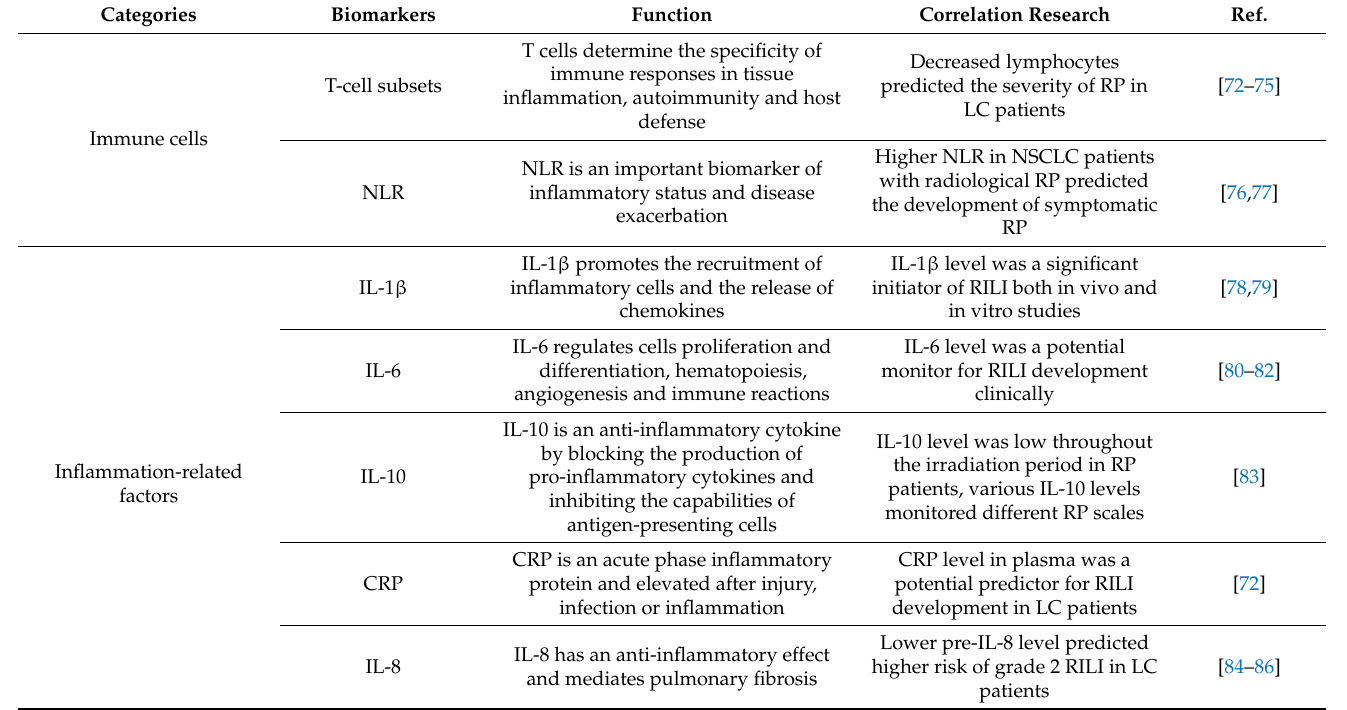
Table 1. Potential biomarkers for monitoring radiation-induced lung